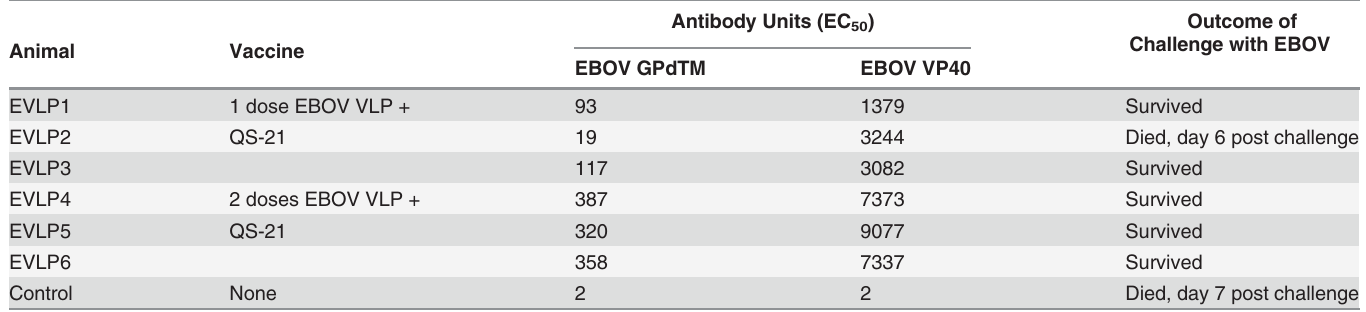
Table 1. Protection afforded by eVLP vaccines after 1 or 2 doses in cynomolgus macaques.